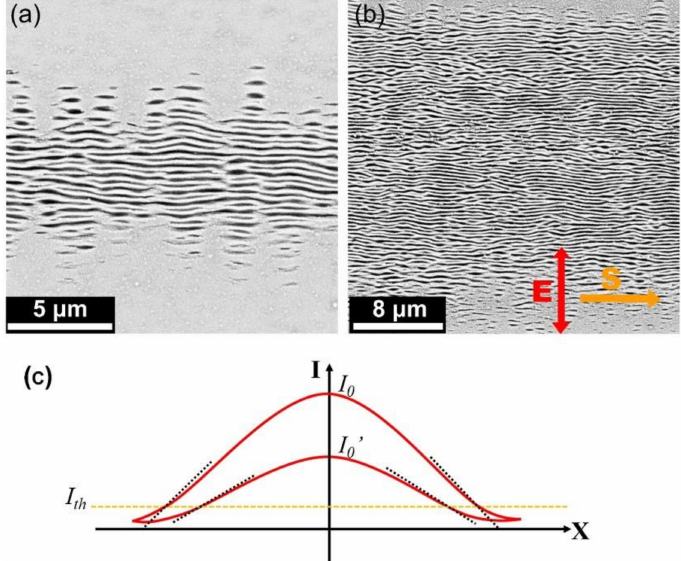
Figure 8. SEM images of the Cr bulk surfaces irradiated by single-beam femtosecond laser pulses with the different energy fluences. ( a ) F = 25.7 mJ/cm 2 ; ( b ) F = 29.6 mJ/cm 2 ; ( c ) Variation rates (dot curves) of the laser intensity at the damage threshold ( I th ) for two cases of different pulse energy fluences, where I 0 and I 0 (cid:48) are the peak intensities of two laser